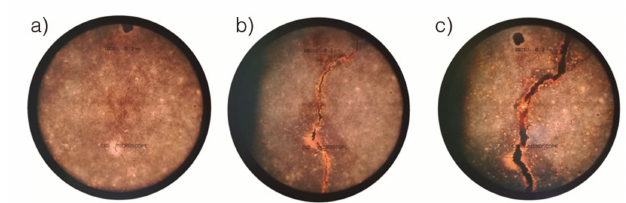
Figure 7. Microscopic observation of the evolution of a crack corresponding to one of the tested specimens. ( a ): Three days of passing current; ( b ): 11 days; ( c ): 23